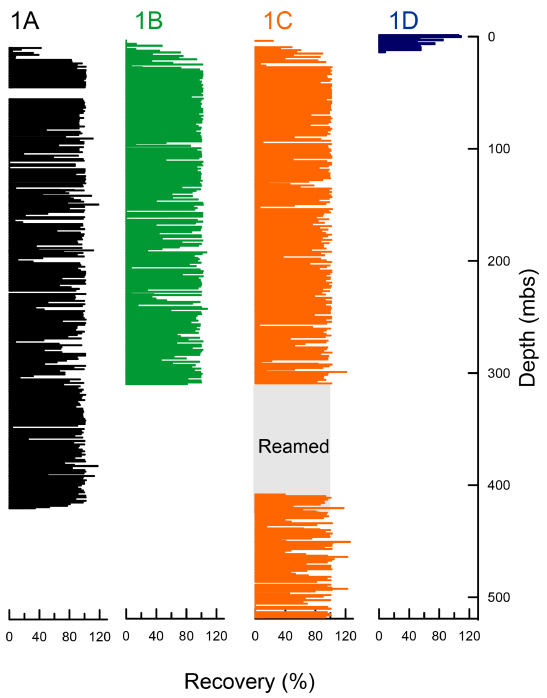
Figure 7. Core recovery from holes 1A, 1B, 1C, and